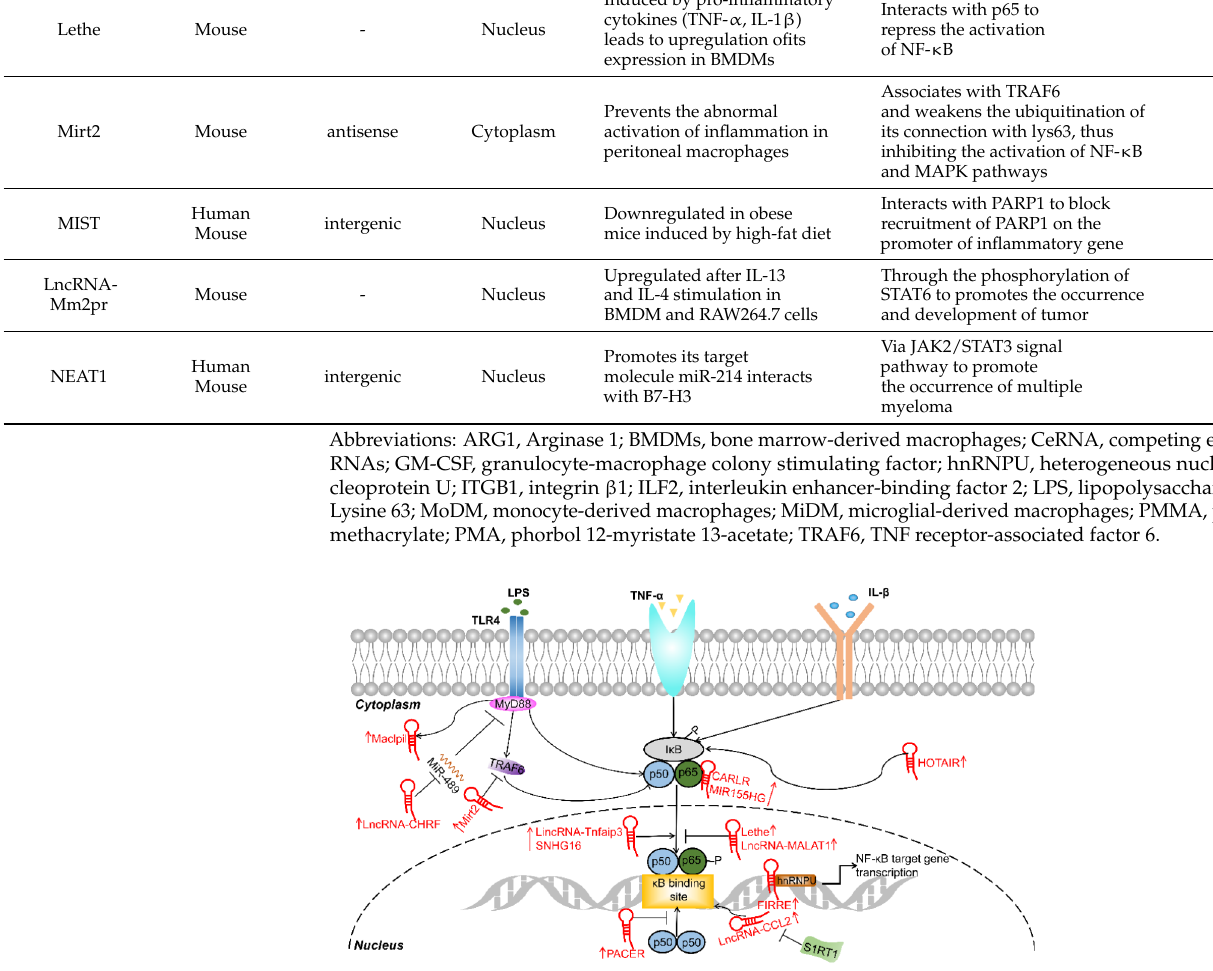
Figure 1. LncRNAs regulate the NF- κ B signaling pathway. LncRNA-CHRF, Mirt2, Lethe, MALAT1, and PACER suppress the NF- κ B signaling pathway. LincRNA-Tnfaip3, SNHG16, CARLR, MIR155HG, HOTAIR, and lncRNA-CCL2 active the NF- κ B signaling